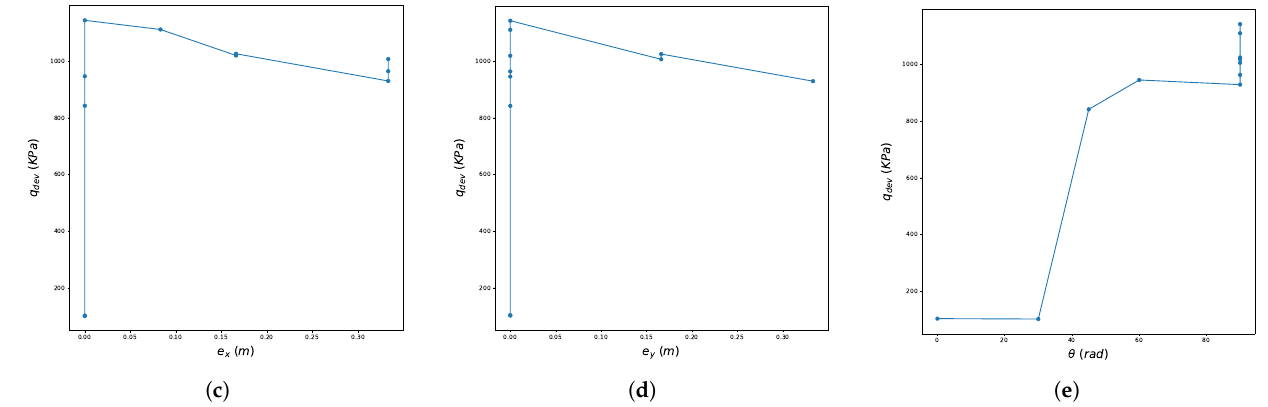
Figure 8. Graphical presentation of the Neural Network that corresponds to Monte Carlo analysis P - κ RF - c RF - k RF − 2 − 9 (NN9) for the estimation of the deviatoric component of the stress q dev in kPa. ( a ) 3D representation of the Neural Network. ( b ) Epochs-Loss diagram. ( c ) Neural Network representation in the projection to the input axis of e x . ( d ) Neural Network representation in the projection to the input axis of e y . ( e ) Neural Network representation in the projection to the input axis of θ .